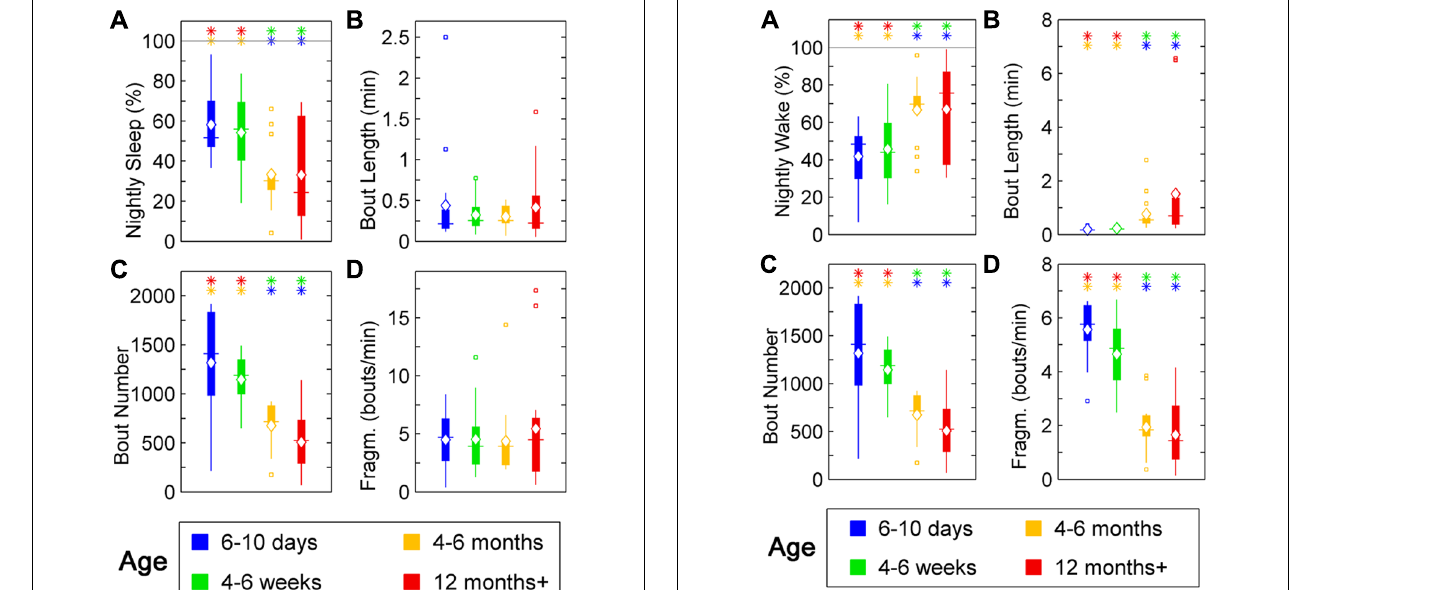
FIGURE 4 | Sleep parameters for zebrafish during the night for age groups: 4–6 days post-fertilization (group 1, blue), 4–6 weeks (group 2, green), 4–6 months (group 3, orange), and 12 months + (group 4, red). Colored asterisks above bars indicate a statistically significant difference between the bar group and the group with the corresponding color of the asterisk. (A) Percentage sleep time. Larvae (groups 1 and 2) sleep significantly more than adult fish (groups 3 and 4) during the dark-phase. (B) There is no significant change in the mean sleep bout duration between the age groups. (C) Number of sleep bouts. Larvae (groups 1 and 2) show significantly more sleep–wake transitions than adult fish (groups 3 and 4). (D) Sleep bout fragmentation (bouts/min). No changes of the fragmentation of sleep are observed across the age groups. Diamond, white line, and squares indicate mean, median, and outlier values, respectively.